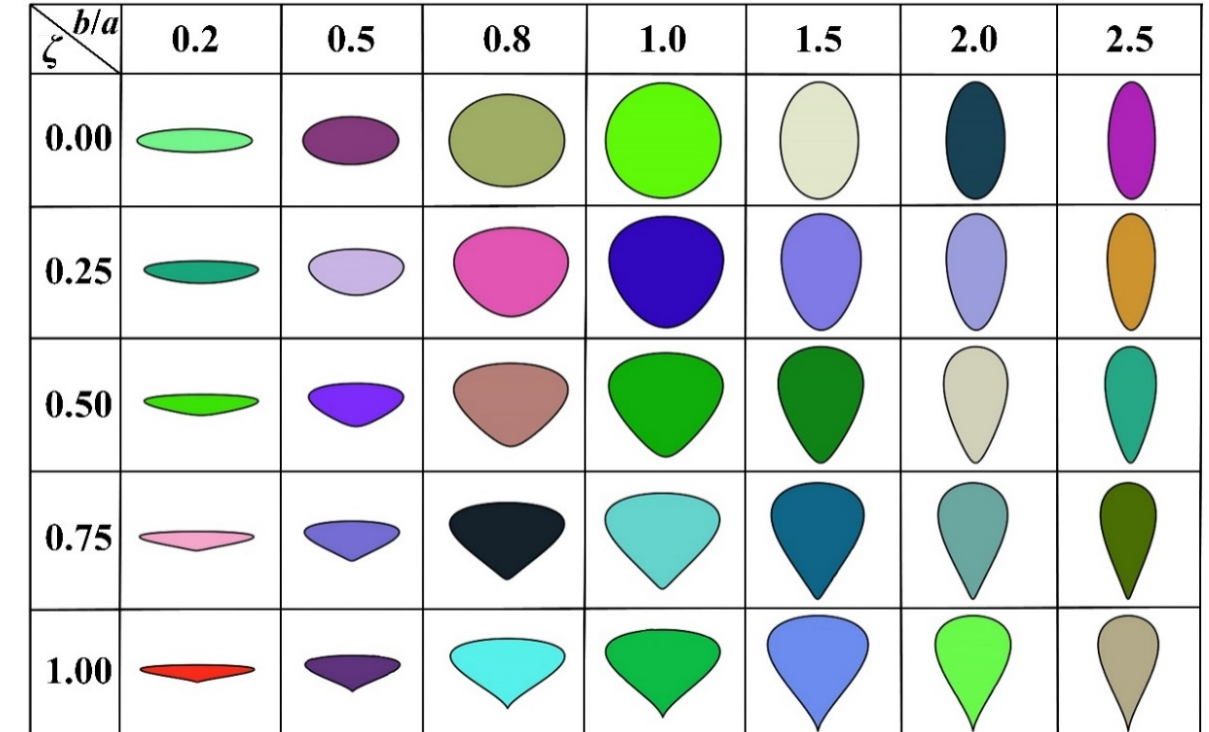
Figure 2. The geometric shapes of ovals with different aspect ratio b / a and tapering coefficient ζ .